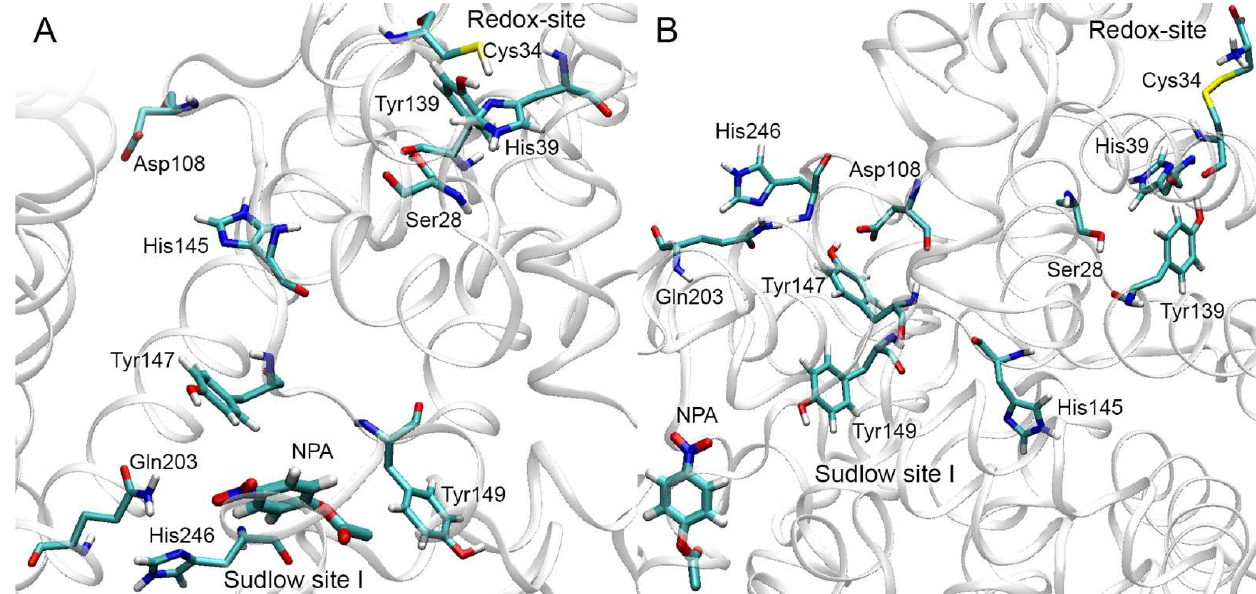
Figure 9. Effect of cysteinylation of Cys34 on the interaction of NPA with Sudlow site I of BSA according to MD simulation. ( A ) NPA remains inside Sudlow site I of native BSA; ( B ) NPA leaves Sudlow site I of cysteinylated BSA due to the conformational changes in BSA structure induced by cysteinylation.